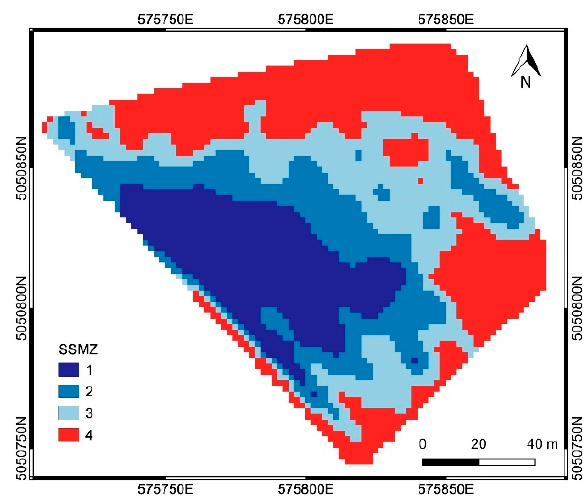
Figure 11. The SSMZ map obtained from the EC maps relative to frequencies 15 kHz and 10 kHz. SSMZ from 1 to 4 corresponds to decreasing EC values; in particular, SSMZ 4 corresponds to negative EC values, due to gravelly soils.